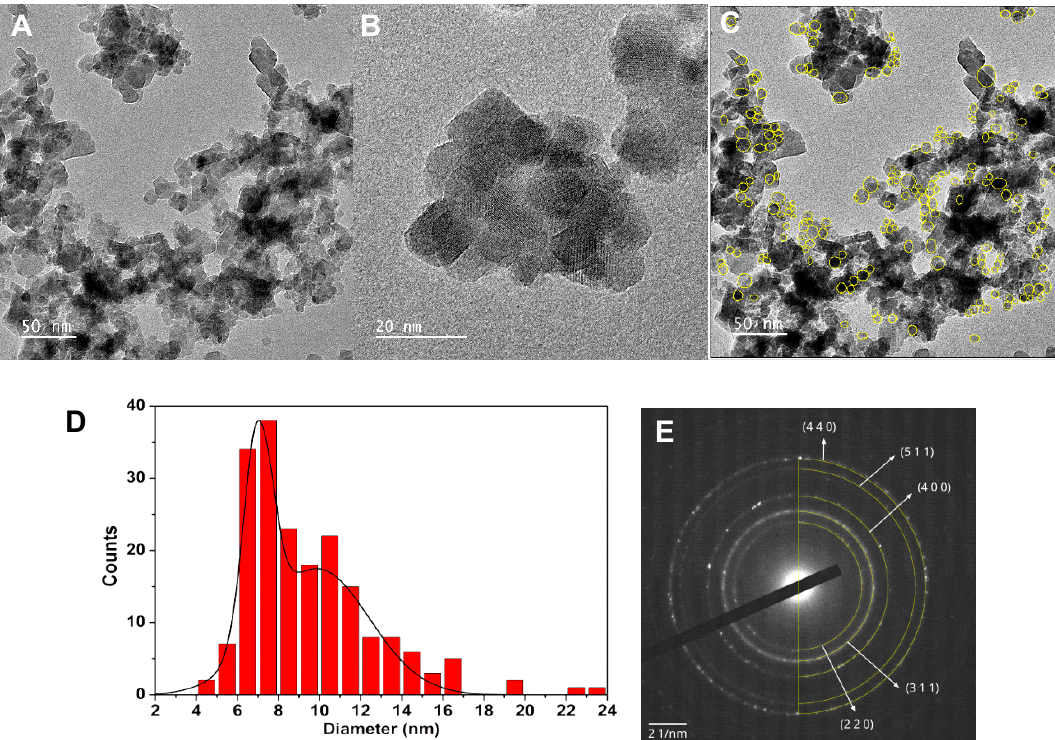
Figure 4. ( A , B ): Transmission electron microscopy images of Ca 0.50 Mg 0.50 Fe 2 O 4 nanoparticles with different magnifications. ( C ): Image ( A ) with outlined nanoparticles. ( D ): Size histogram of image ( A ). ( E ): Small area electron diffraction (SAED) image with indexed diffraction planes.